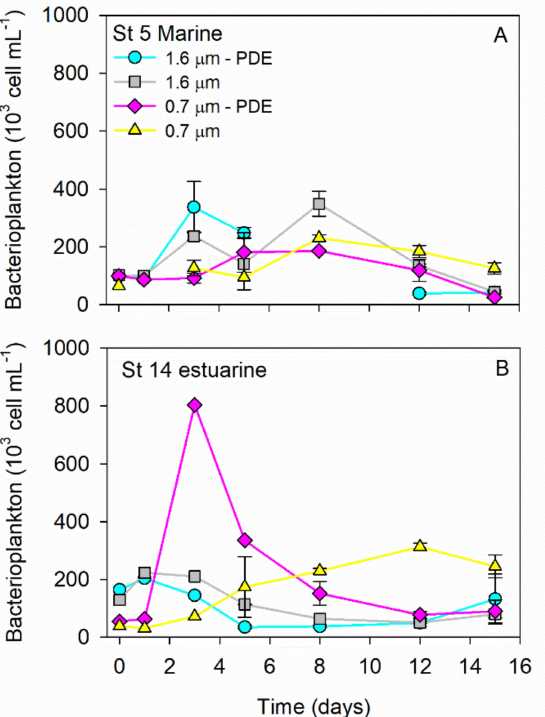
Figure 4. Non-fluorescent picoplankton abundance (10 3 cell mL − 1 ) from the different treatments, with PDE addition and controls, and for the different size fraction of natural bacterial assemblages (0.7 µ m and 1.6 µ m). The upper panel corresponds to marine station 5 ( A ) and the lower panel to estuarine station 14 ( B